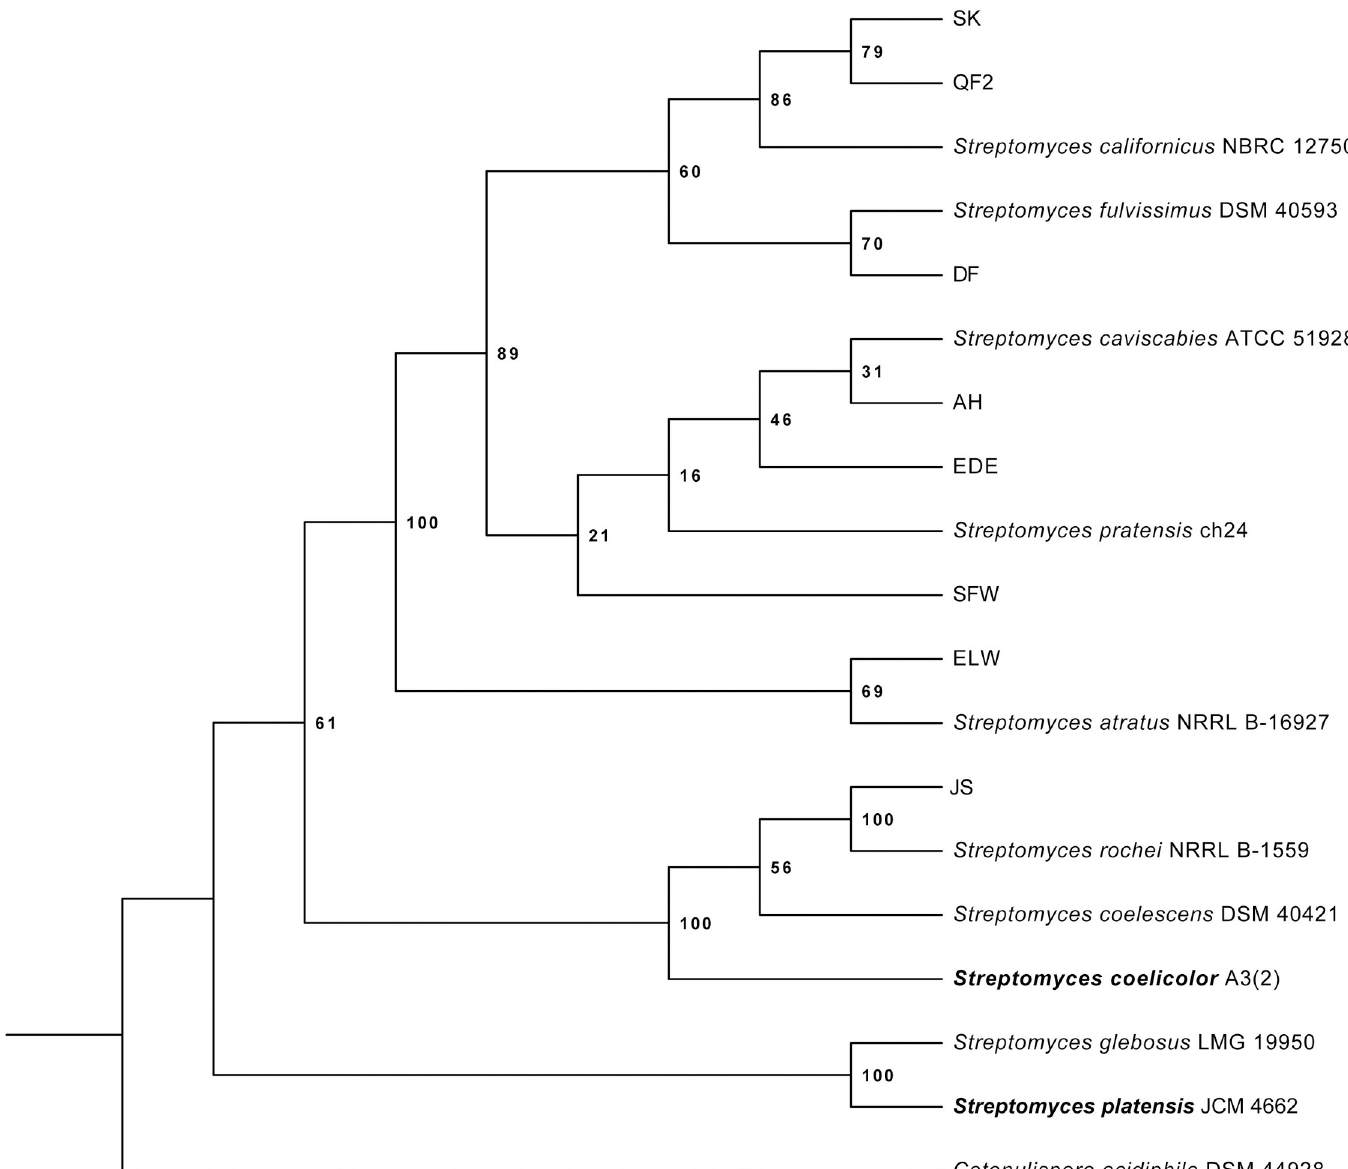
Fig 1. The maximum likelihood phylogeny of Streptomyces bacteria isolated from soil samples. This phylogenetic tree was constructed by aligning PCR-amplified 16S rRNA sequences with MUSCLE and analyzing with RAxML. Laboratory strains A3(2) and JCM 4662 (in bold) and all type strains are named.